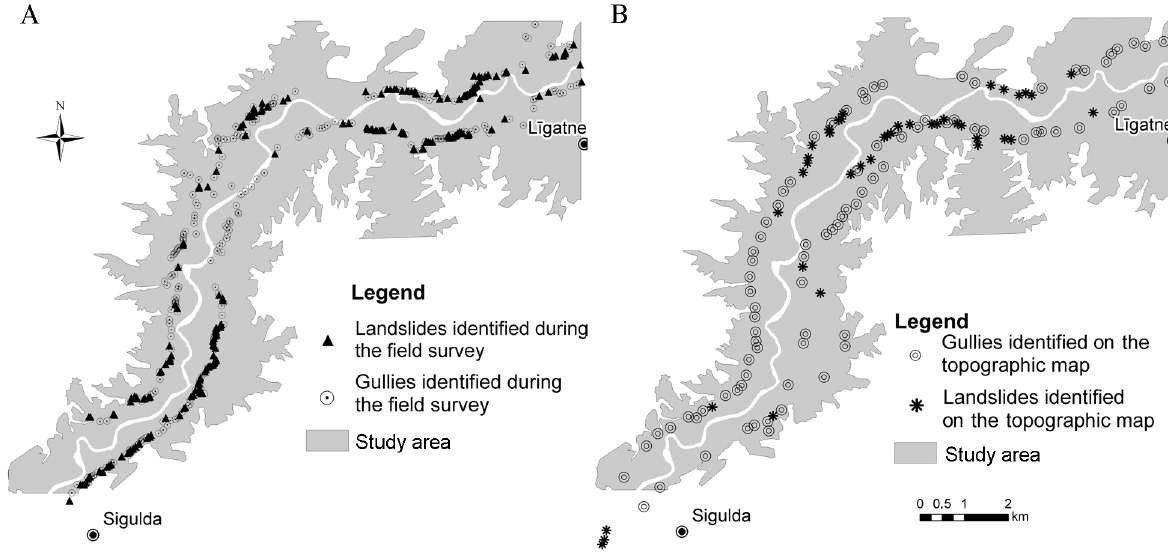
Fig. 4. Landslides and gullies identified in the study area from the field survey (A) and on 1 : 10 000 topographic maps